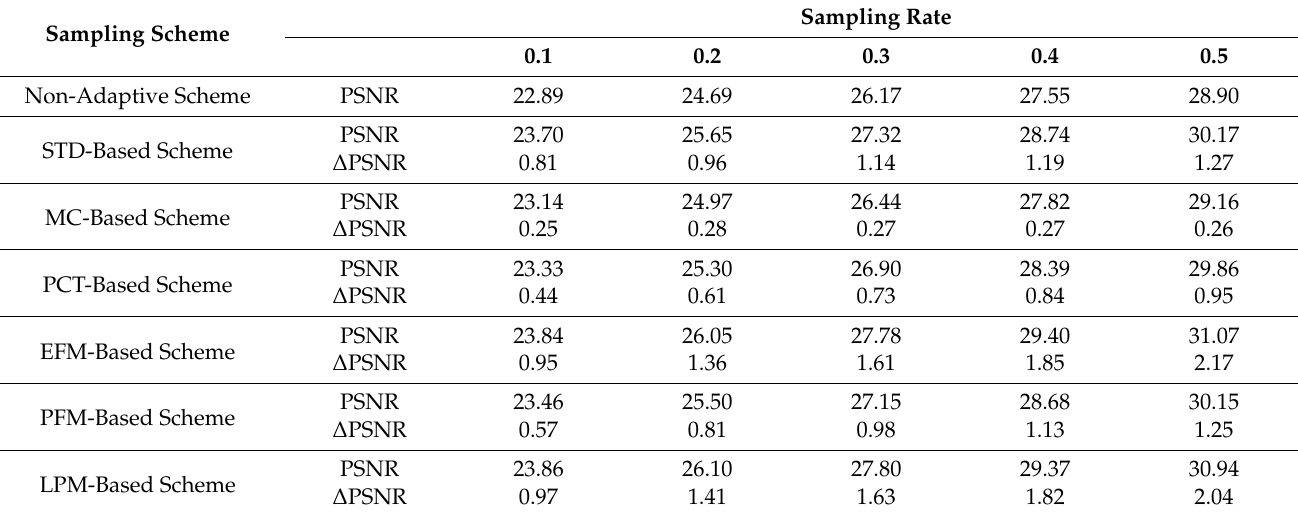
Table 3. Average PSNR (dB) of BSD68 datasets for different ABCS